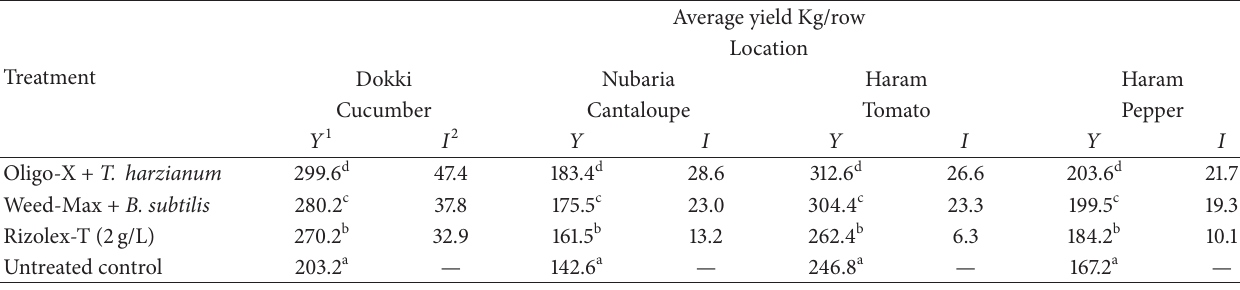
Table 4: Effect of applied algae compounds and bio-agent formula on produced yield of some vegetables grown in plastic houses under protected cultivation system at different